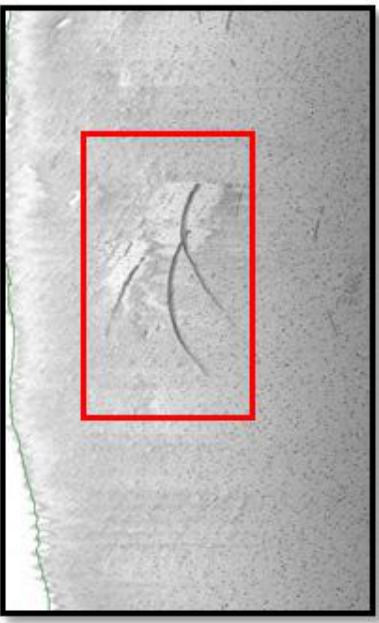
Figure 5. The backscatter image showing variation grey scale of different features such as grass and rock at downstream area (smoothest textures)